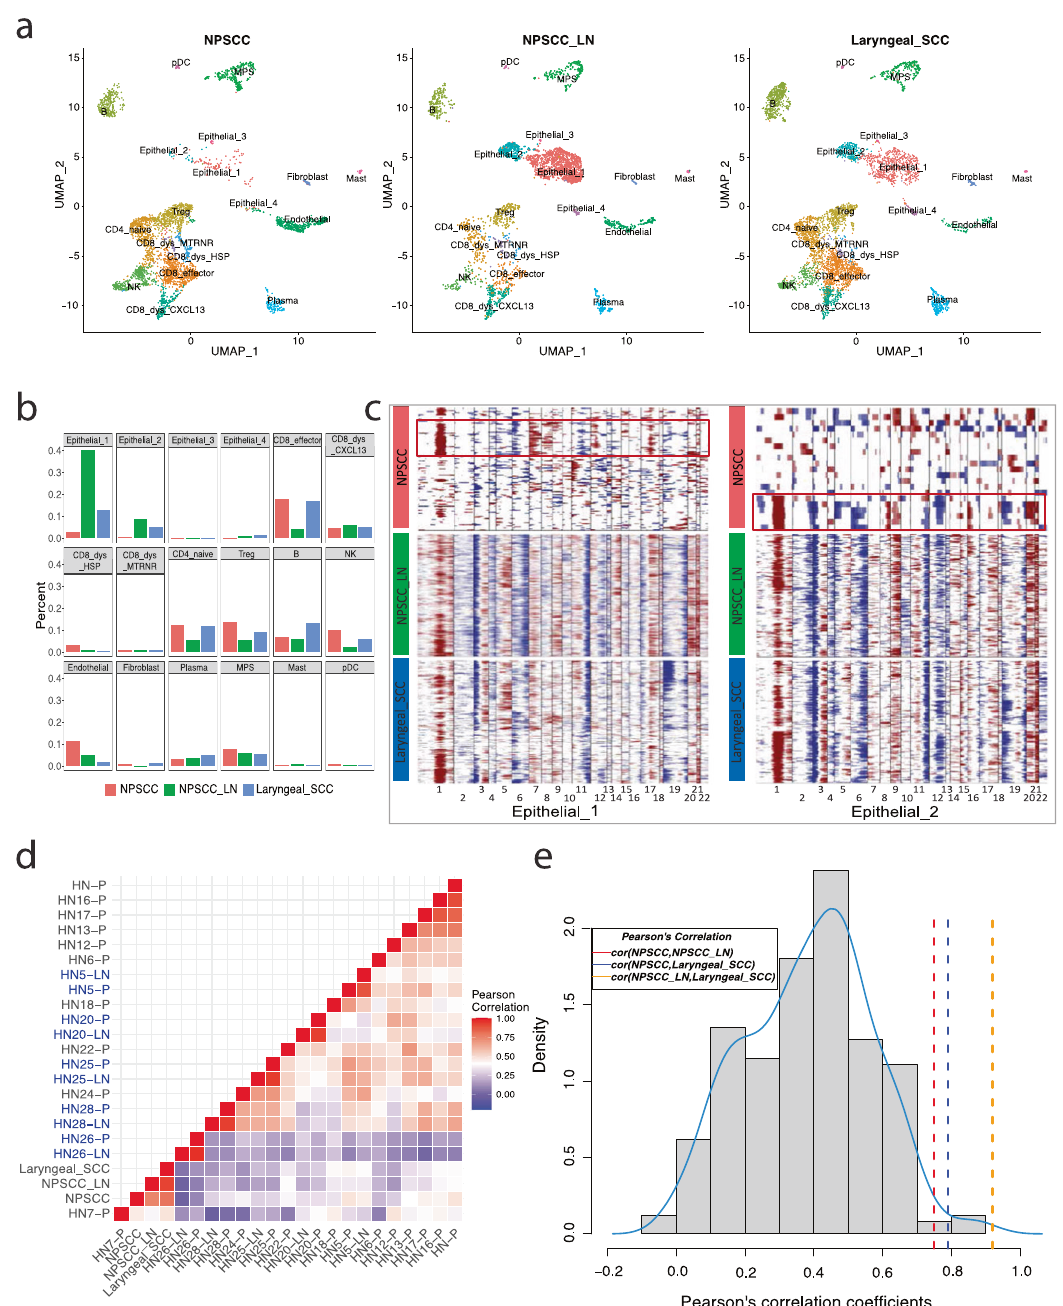
Fig. 2 Copy number alteration pro fi les suggest the newly developed laryngeal SCC is a metastasis from the NPSCC, as opposed to a new primary tumor. a UMAP plots and b bar graphs show different cell compositions among three tumors. Dysfunctional CD8 + T cells were split into three subtypes by their marker genes: CD8_dys_CXCL13 with marker gene CXCL13, CD8_dys_HSP with heat shock proteins, and CD8_dys_MTRNR with mitochondrially encoded RNA genes. NPSCC and NPSCC lymph node have distinct components of malignant cells especially Epithelail_1 and Epithelial_2 clusters, demonstrating the inter-tumor heterogeneity. c Heatmap of copy number alteration pro fi les inferred from two main malignant cell clusters of three tumors using T cell and B cell as “ normal ” references. Dark red indicates genomic ampli fi cations and blue indicates deletions. The x-axis shows all autosomes in numerical order. The y-axis displays epithelial cells from different tumors (left: Epithelial_1; right: Epithelial_2). Nearly identical copy number alterations observed between the NPSCC lymph node and the laryngeal SCC are similar to those of subclones of the NPSCC tumor (red box). d Heatmap of Pearson ’ s correlation matrix of 23 HNSCC tumors ’ CNA pro fi les. Correlation coef fi cients were calculated using mean CNA levels of tumors inferred from scRNA-seq using inferCNV. Five matched pairs of primary tumors (-P) and lymph node metastases (-LN) are in blue font. Matched pairs and three HNSCC tumors investigated in this study show higher similarity within the pairs (red squares), than between unpaired tumors. e Histograms of Pearson ’ s correlation coef fi cients of non-paired HNSCC tumors ’ CNA pro fi les, excluding the fi ve matched pairs and three tumors investigated in this study. Three tumors investigated here show higher similarity ( r = 0.75, 0.79, and 0.92) than that would be expected randomly, with one-sided p -values of 0.023, 0.013, and 0.0017,